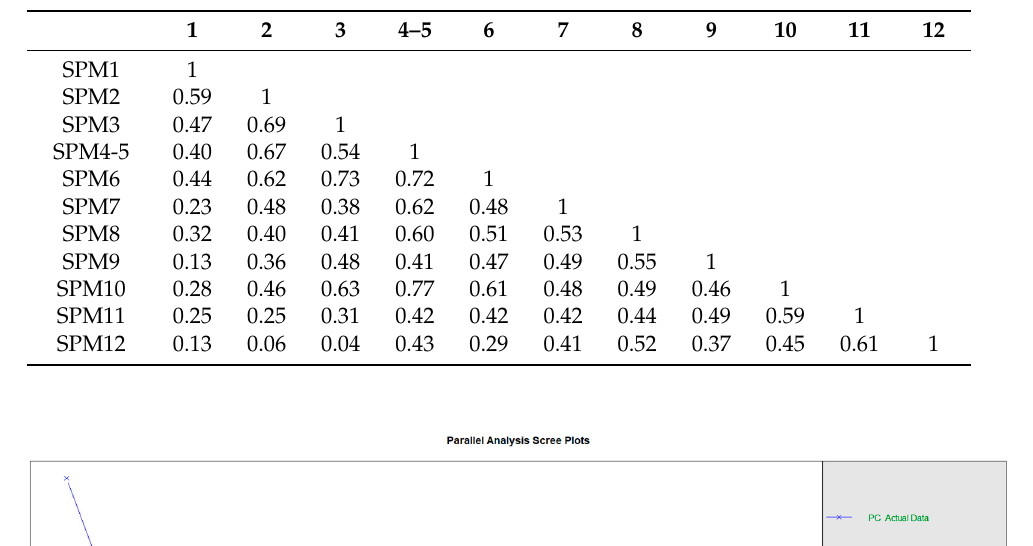
Table A1. Tetrachoric / polychoric correlation matrix with SPM4 and SPM5 combined.